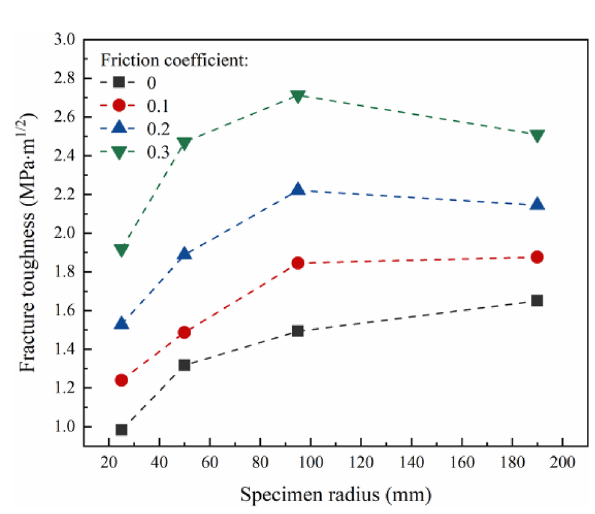
Figure 9. Variation of fracture toughness with specimen size under different friction